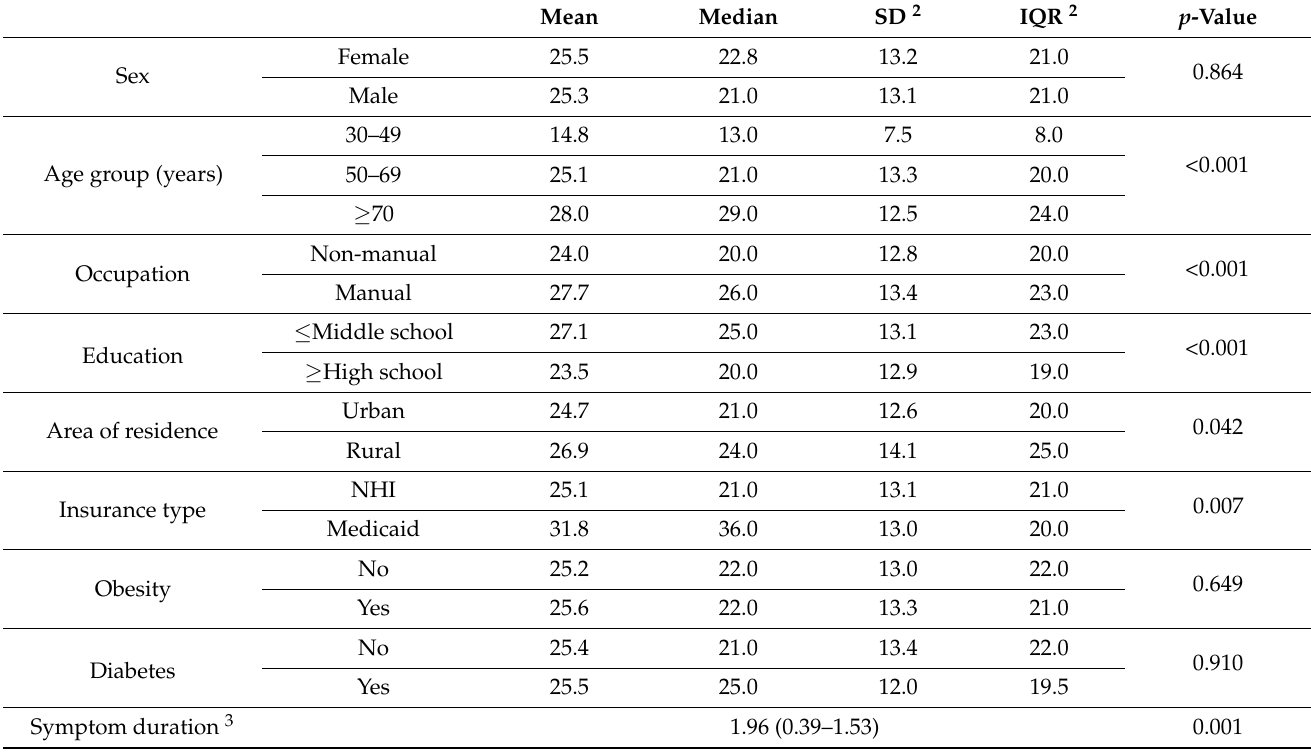
Table 2. Comparison of the non-traumatic full thickness rotator cuff tear sizes (mm) using univariate analysis 1 .